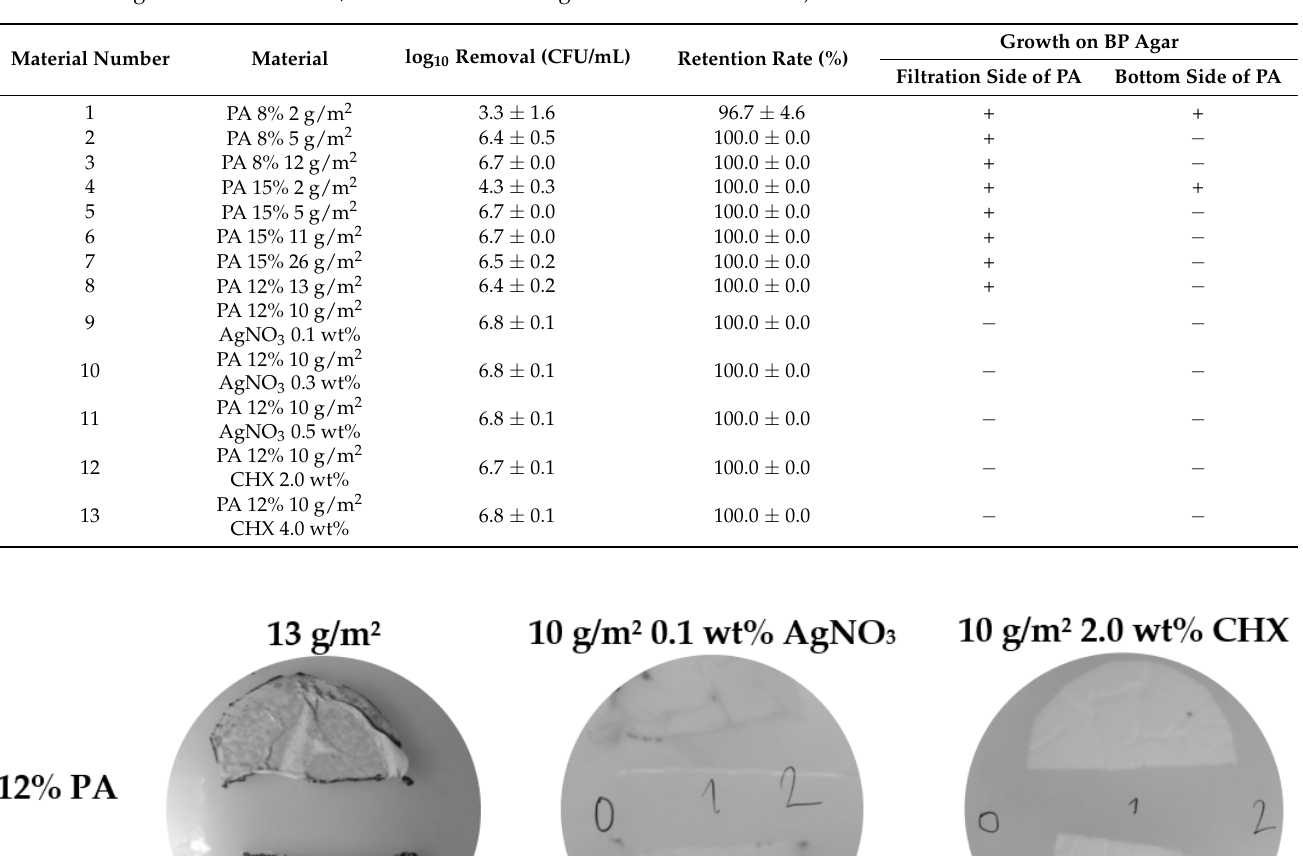
Table 3. Average log 10 removals, retention rates, and visual evaluation of growth on Baird-Parker (BP) agar (“+” means bacterial growth was detected, “ − “ means bacterial growth was not detected) of PAs for S. aureus CCM 4516.